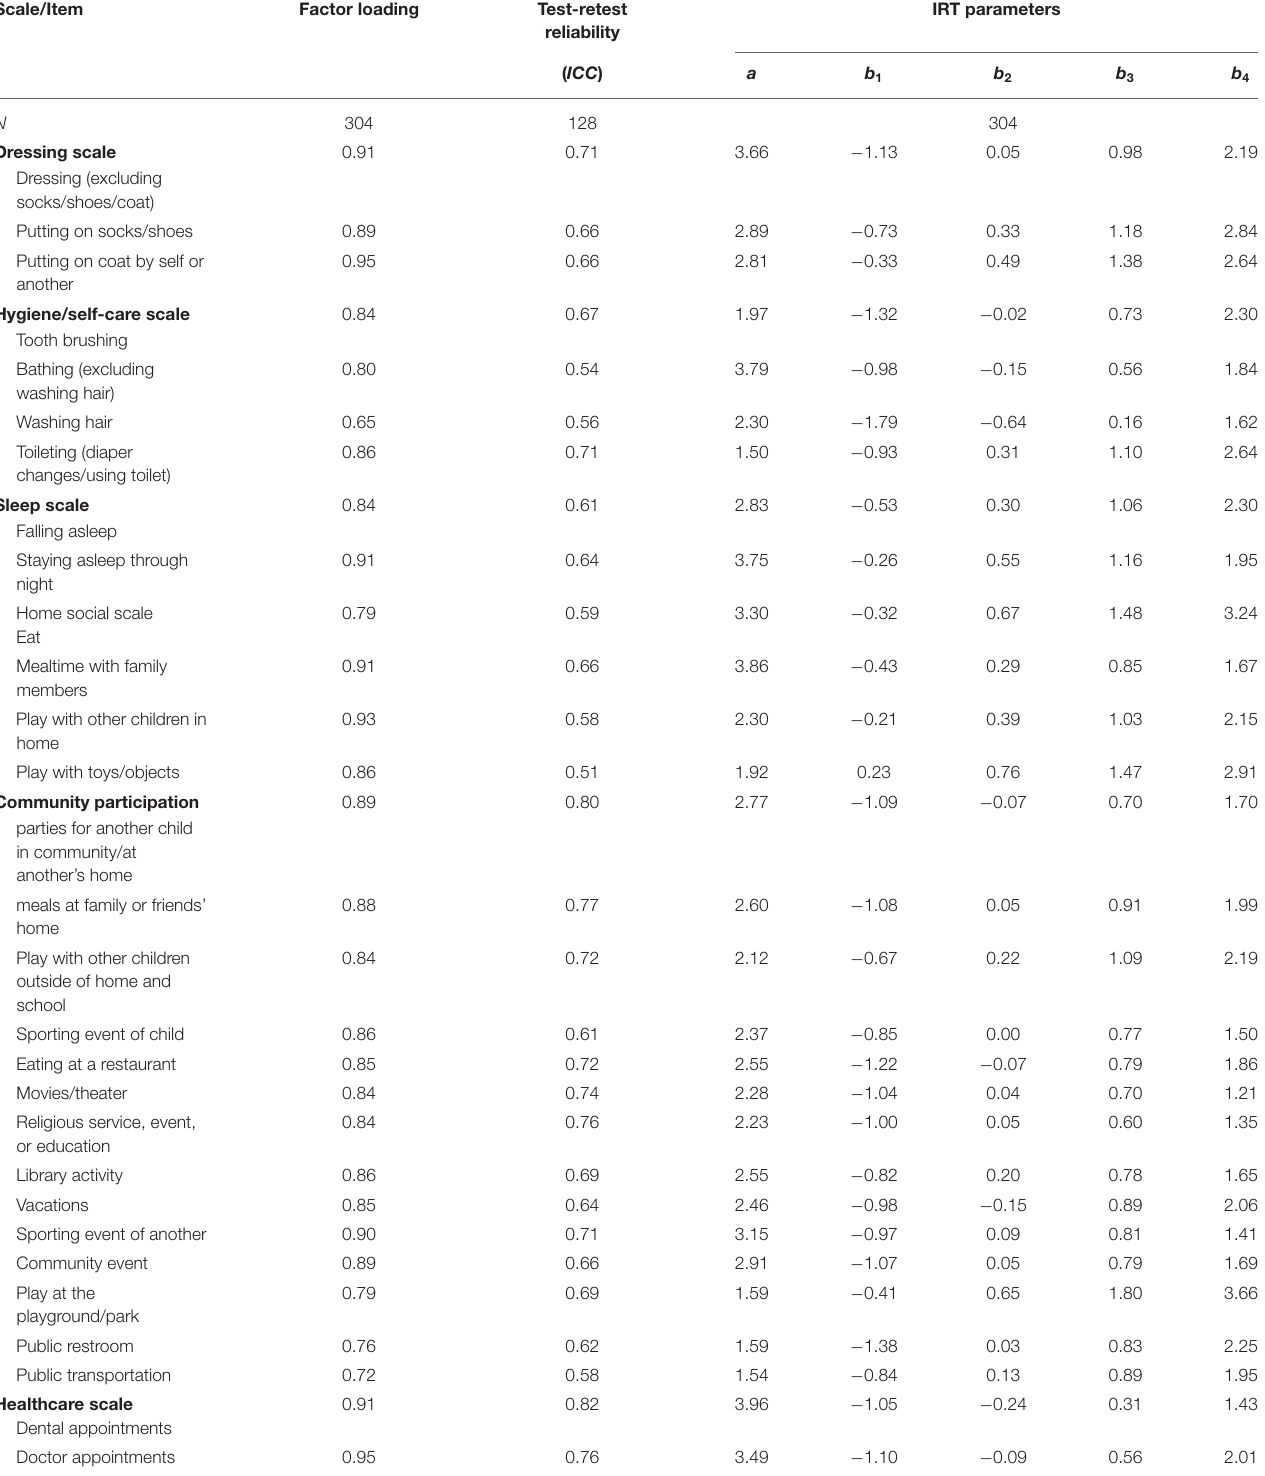
TABLE 4 | Parent Effort Scale (PES) item